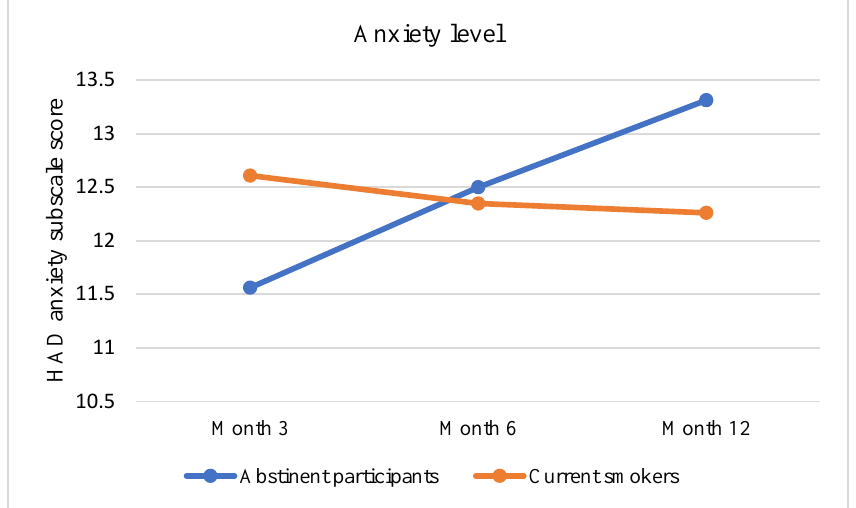
Figure 2. Change in Cough related quality of life as measured by LCQ throughout the study